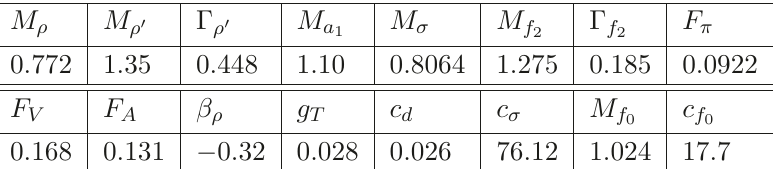
Table 1 . Numerical values of the parameters used to produce the theoretical spectra in 4. All the parameters are in GeV units except for c σ and c f